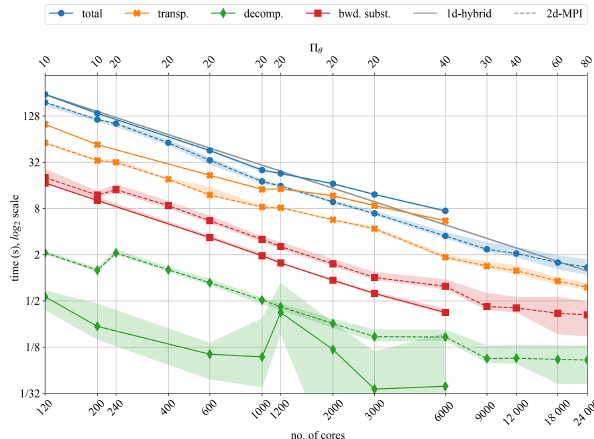
Figure 5. Strong scalability of (cid:96) transposition for 100 time steps of the dynamo benchmark ( N r = 301 and N θ = 960).